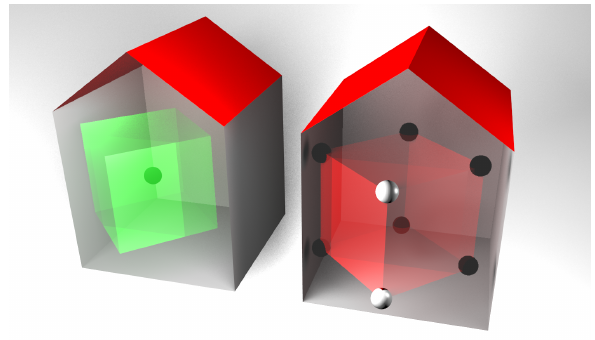
Figure 7: Comparison of different voxel-in-polyhedron ap- proaches. The left building is illustrating the test for the center point of the voxel. This point decides that the voxel is inside the building and the voxel volume is added to the total volume of the building. The right building is illustrating the method for the oc- tree approach. All 8 vertices are tested. If one or more points are outside of the building model the voxel volume is not complete inside.